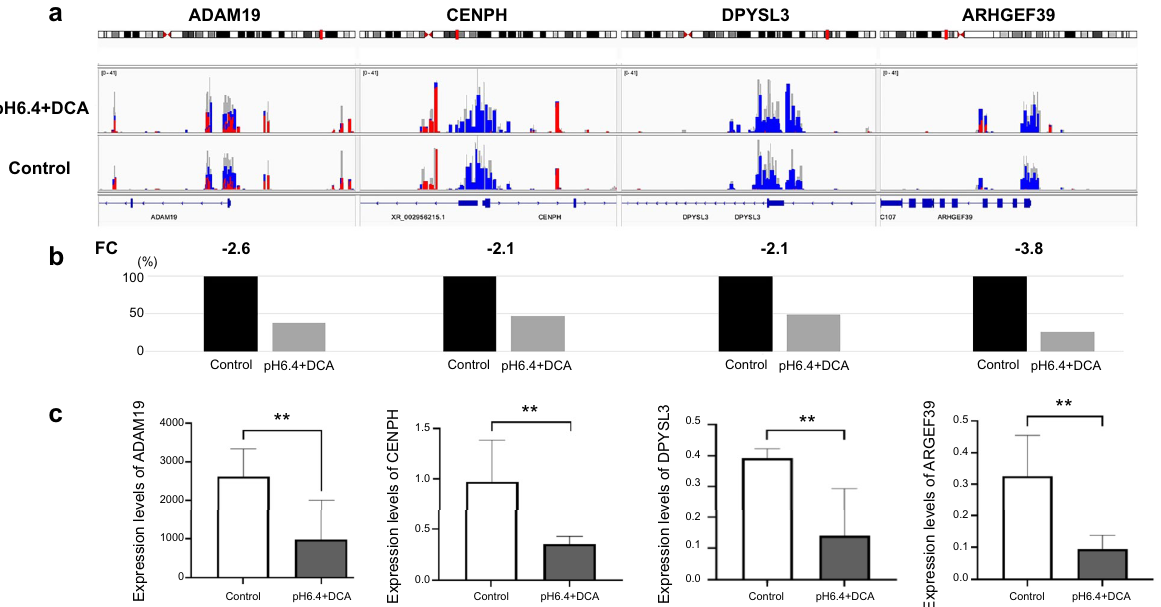
Figure 6. Change in DNA methylation levels at the promoter regions of representative downregulated genes determined using mRNA gene expression arrays and RT-qPCR assays for CP-A cells. ( a ) No change in DNA methylation at the promoter regions in these 4 genes, in which gene expression was downregulated after exposure to acid and DCA in CP-A cells. The promoter region of each gene is shown in red for DNA methylation and blue for demethylation. The promoter region is visualized as a blue box above the gene name. ( b ) Fold-changes of gene expression in these 4 genes determined using mRNA gene expression arrays in CP-A cells with PH6.4 + DCA were seen, when compared with that in CP-A cells without acid and DCA exposure. The percentage of gene expression in control cells was modified to 100%. FC; fold-change of gene expression between PH6.4 + DCA and control. ( c ) The expression levels of these 4 genes determined by RT-qPCR assays were significantly decreased in CP-A cells exposed to pH 6.4 + DCA compared to controls. The statistical significance between groups was determined using a two-tailed Student’s t -test. **p < 0.05.